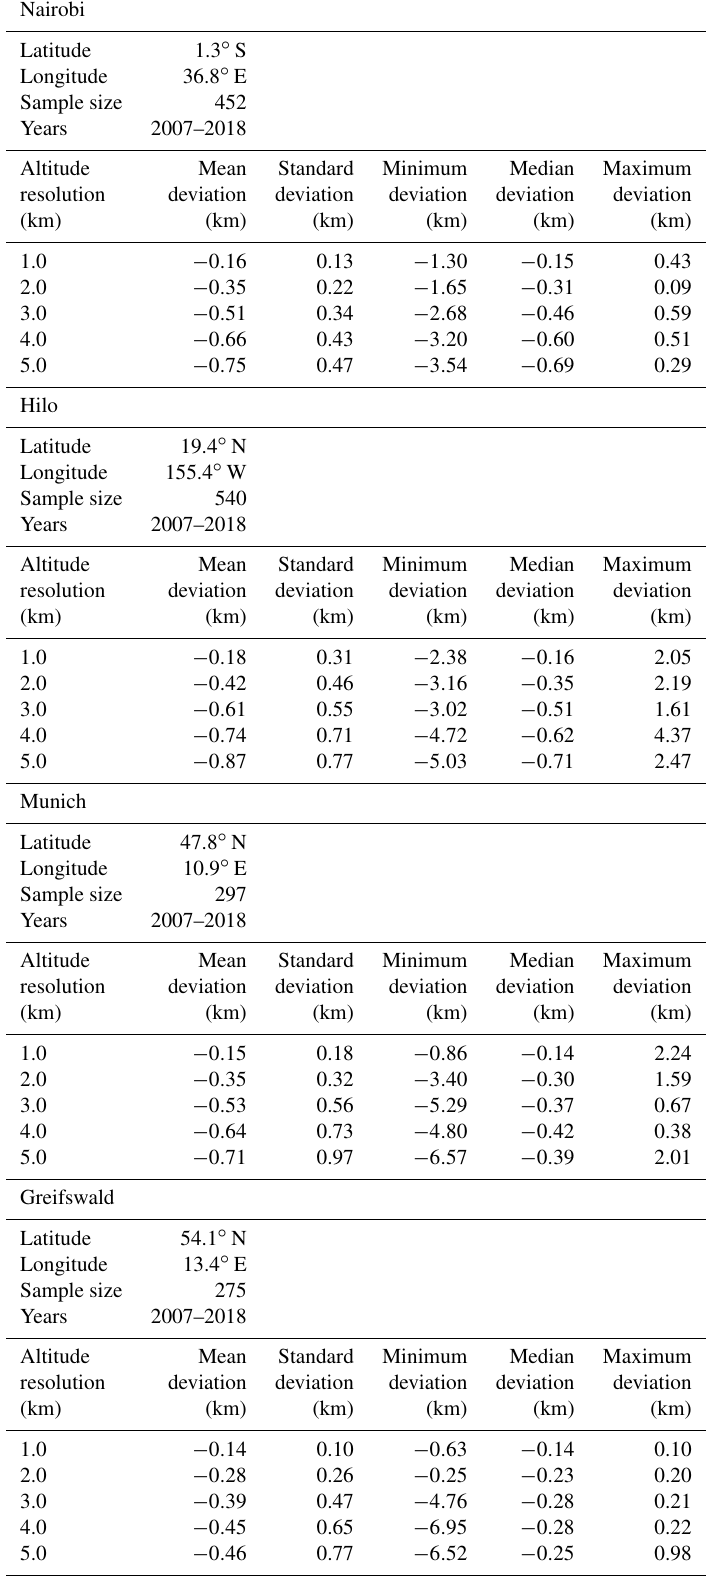
Table 3. Statistics for cold point tropopause